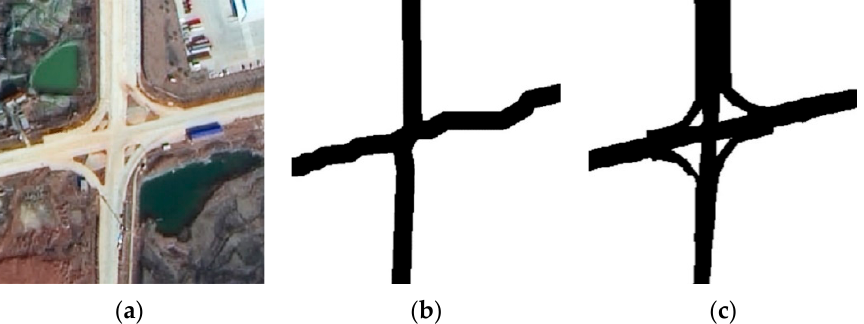
Figure 18. Comparison of intersections with auxiliary roads: ( a ) original image; ( b ) extraction result; ( c ) ground truth.